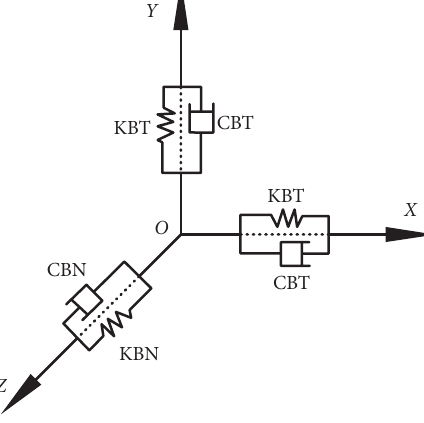
Figure 2: Viscoelastic boundary